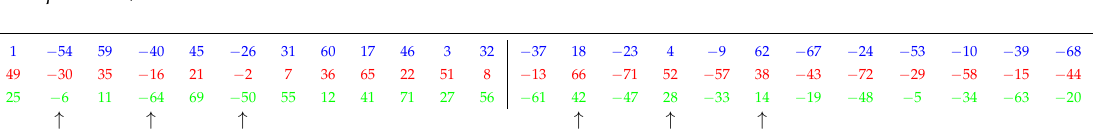
Table 18. Double chording with a 3-rd order double-sided imbrication for N = 72, p = 5, m = 3 and q = 2 + 2 / 5